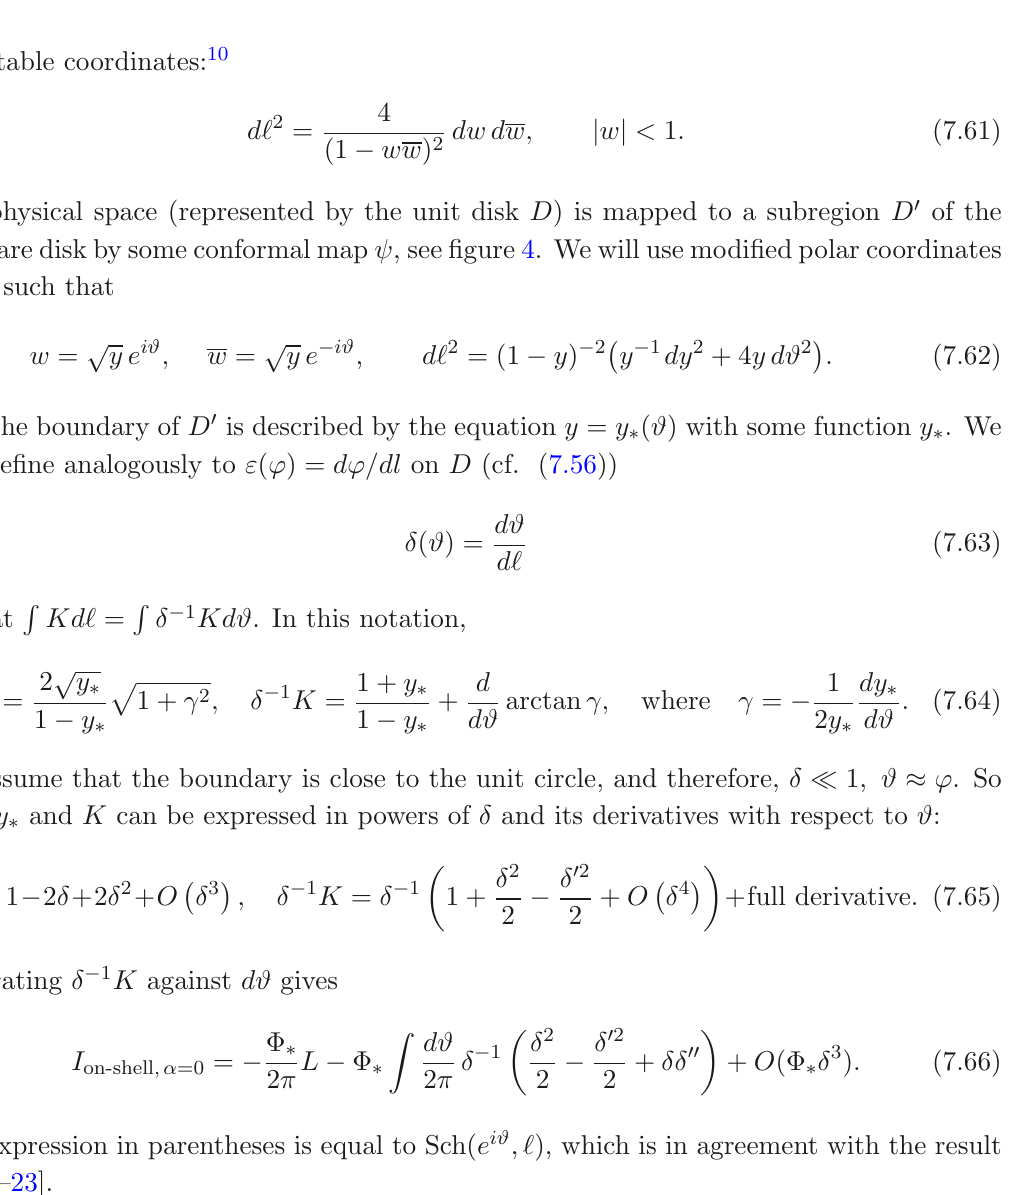
Figure 4 . Map of the physical space (disk D ) to the region D ′ of the Poincare